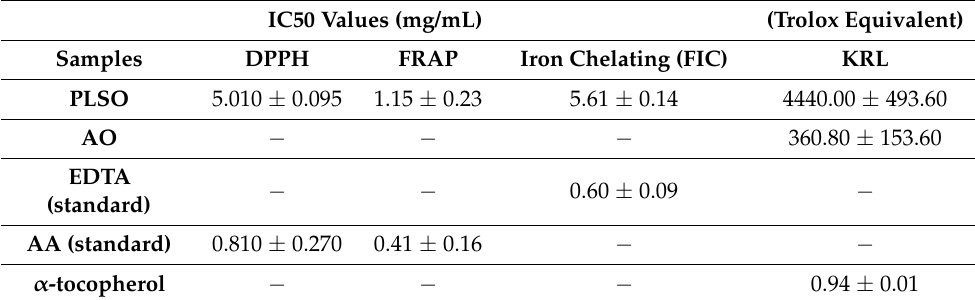
Table 6. Antioxidant activity of Pistacia lentiscus seed oil (PLSO).